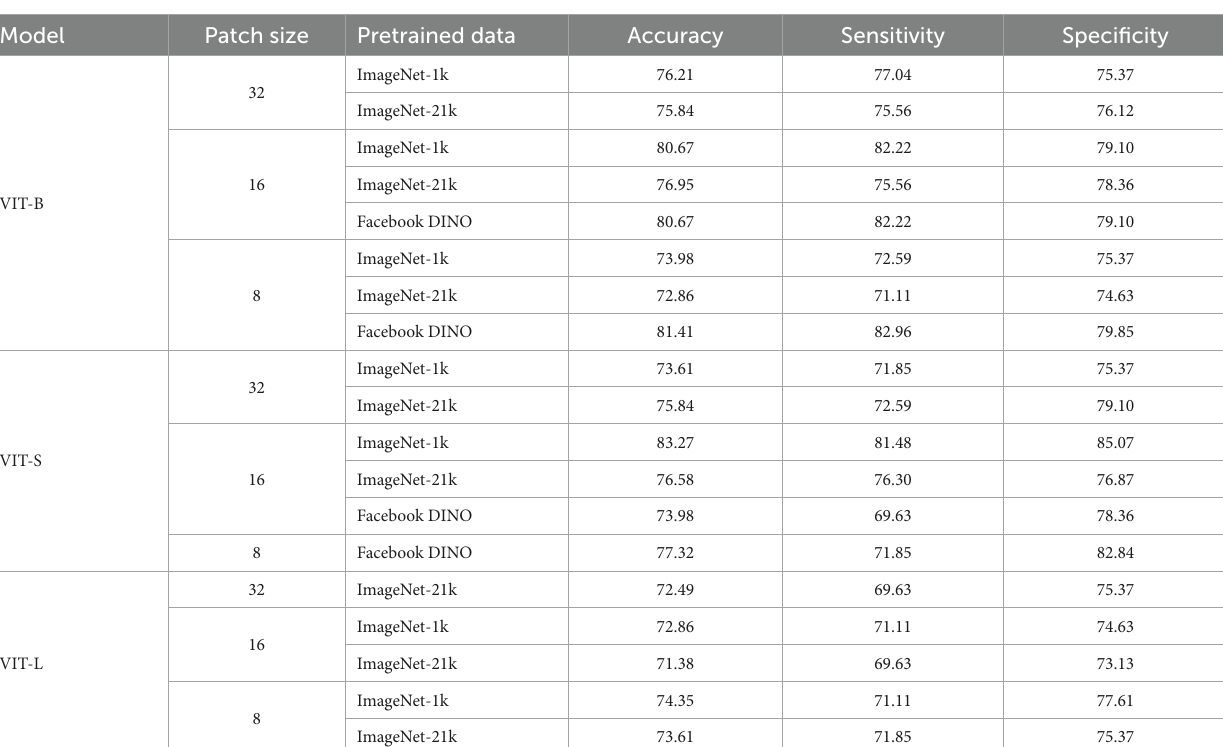
TABLE 3 Ablation study on the effectiveness of transformers.